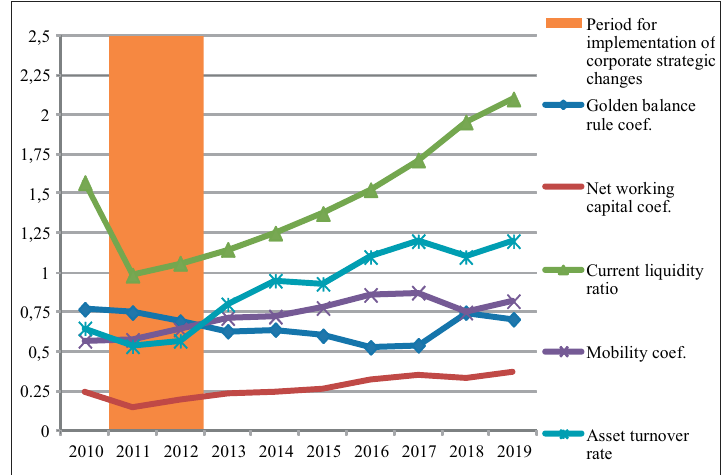
Fig. 6. Dynamics of financial leverage indicators of the enterprise provided strategic changes were